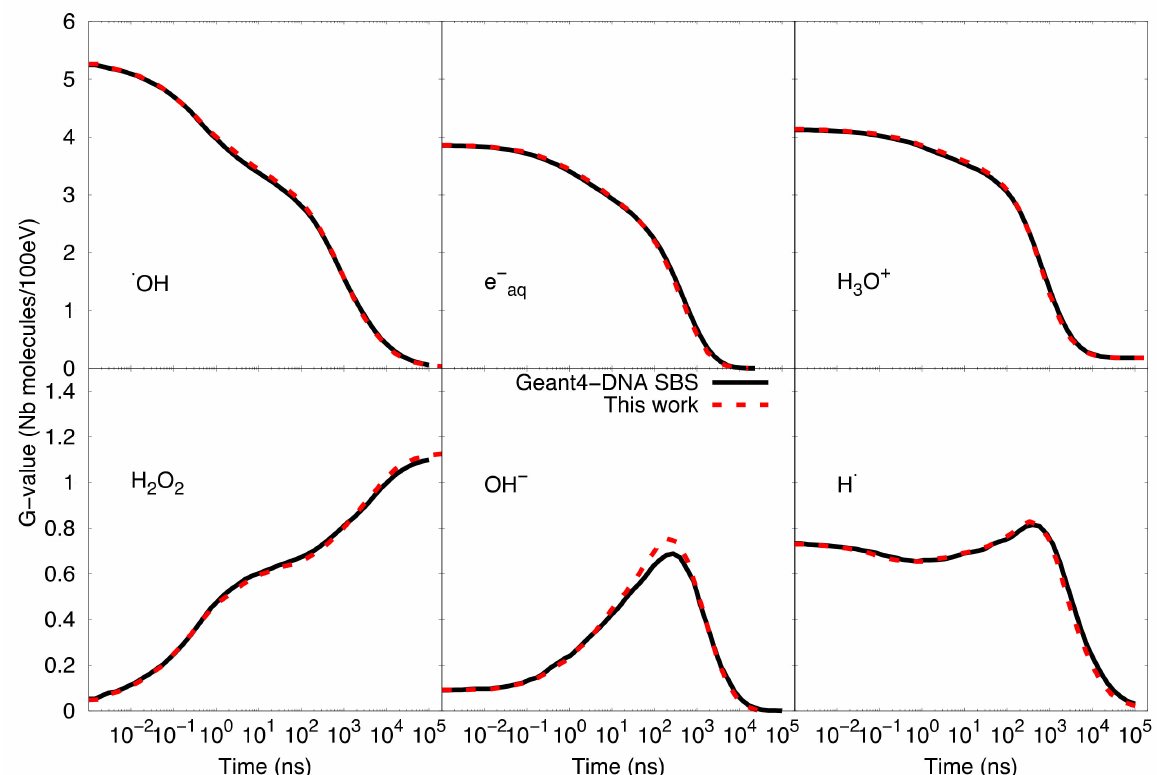
Figure 3. Comparison of time-dependent G-values as computed with the particle-based SBS model and the SBS-RDME model (this work) from 1 ns until 100 µ